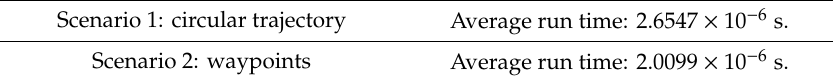
Table 7. Run time of proposed control method with respect to two testing